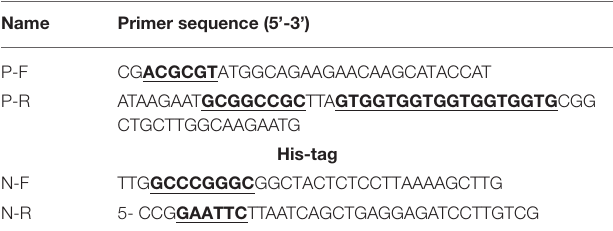
TABLE 1 | The primers used for plasmid